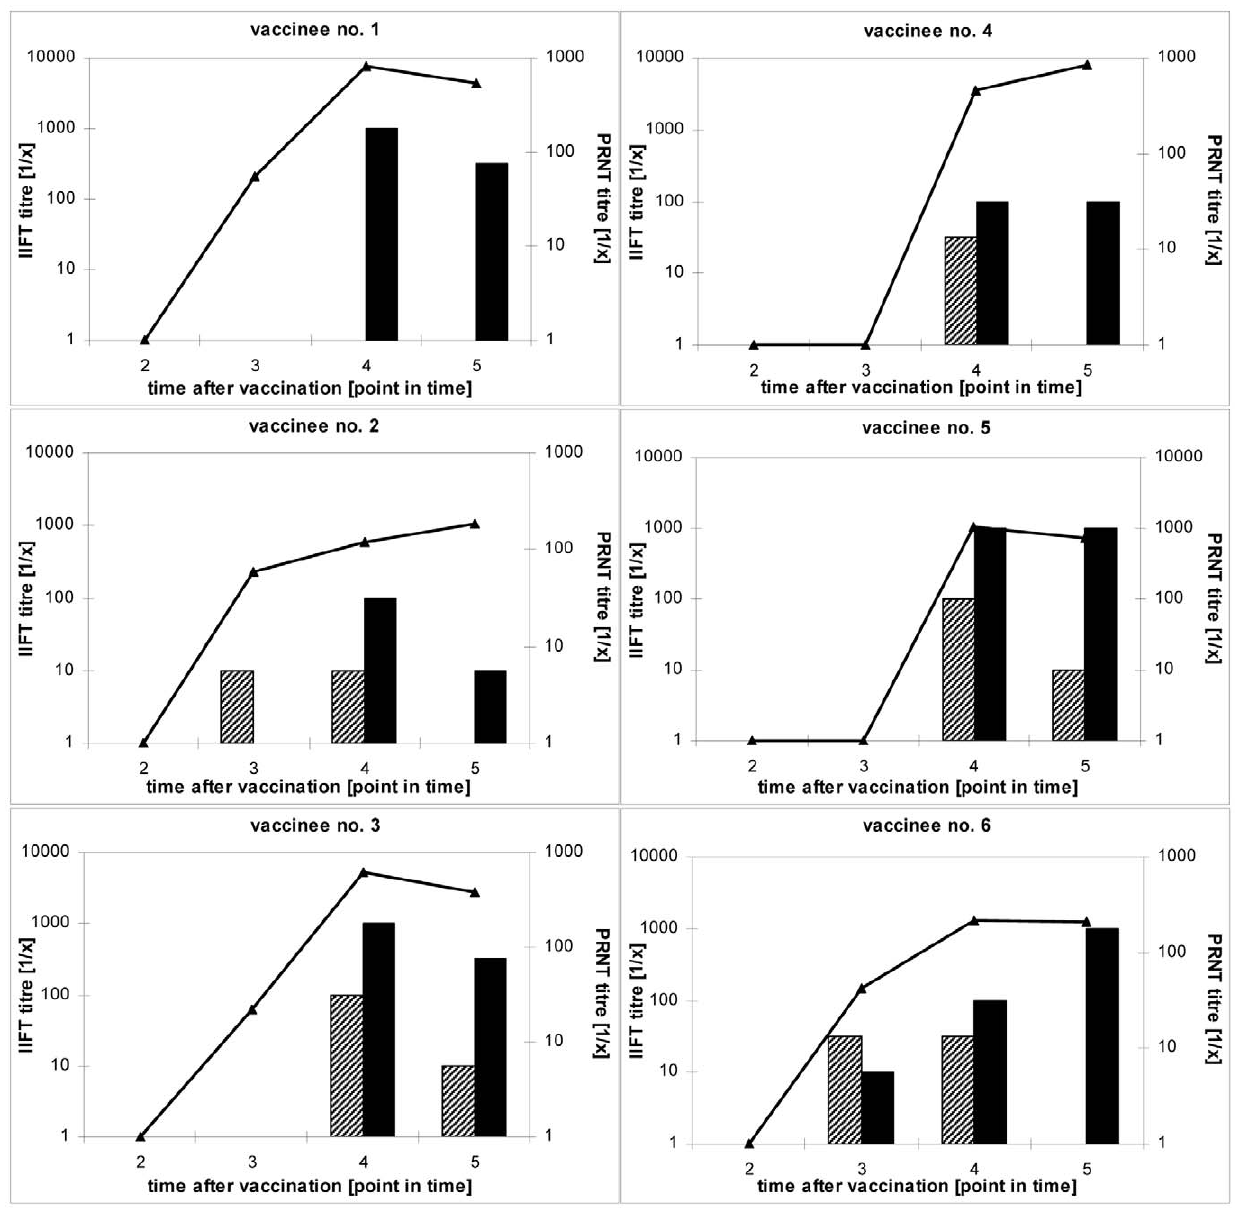
Figure 4. Exemplary courses of serological IgM, IgG and neutralizing antibody titres, determined by the EUROIMMUN IgM and IgG IIFT and the PRNT50. Test values: IgM IIFT titres (striped boxes), IgG IIFT titres (filled boxes), PRNT50 titres